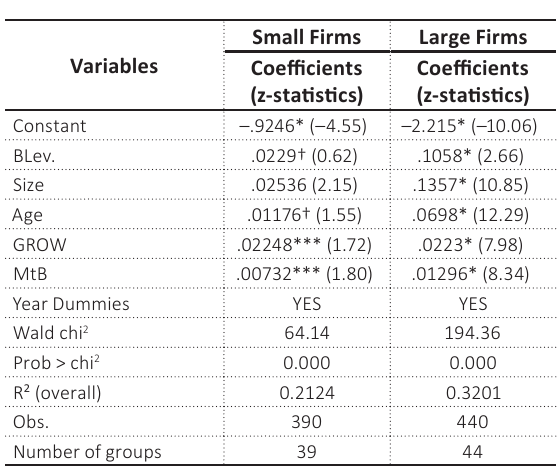
Table 7. Regression results (capital structure- performance) relying on firm size